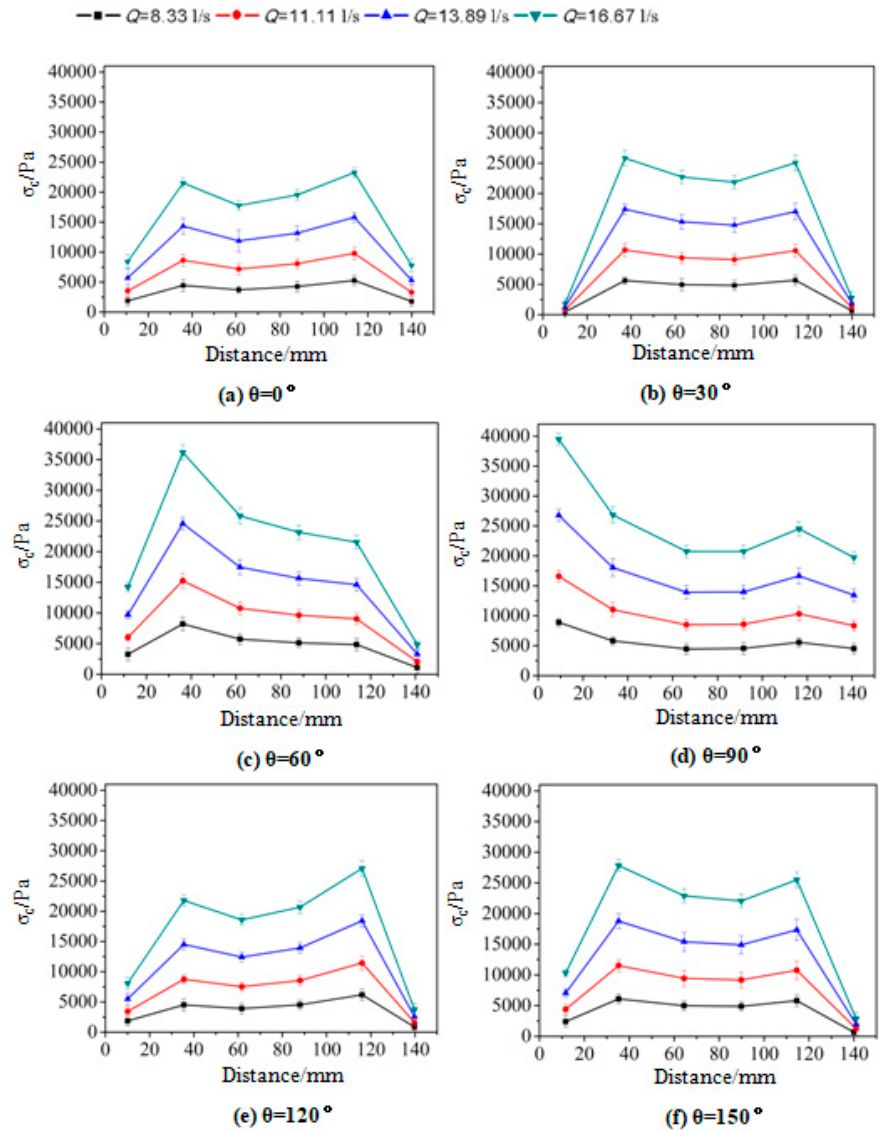
Figure 9. Principal-stress component on capsule surface. ( a ) θ = 0 ◦ ; ( b ) θ = 30 ◦ ; ( c ) θ = 60 ◦ ; ( d ) θ = 90 ◦ ; Figure 9. principal-stress component on capsule surface. ( a ) θ = 0°; ( b ) θ = 30°; ( c ) θ = 60°; ( d ) θ = 90°; ( e ) θ = 120 ◦ ; ( f ) θ = 150 ◦ ( e ) θ = 120°; ( f ) θ = 150°.